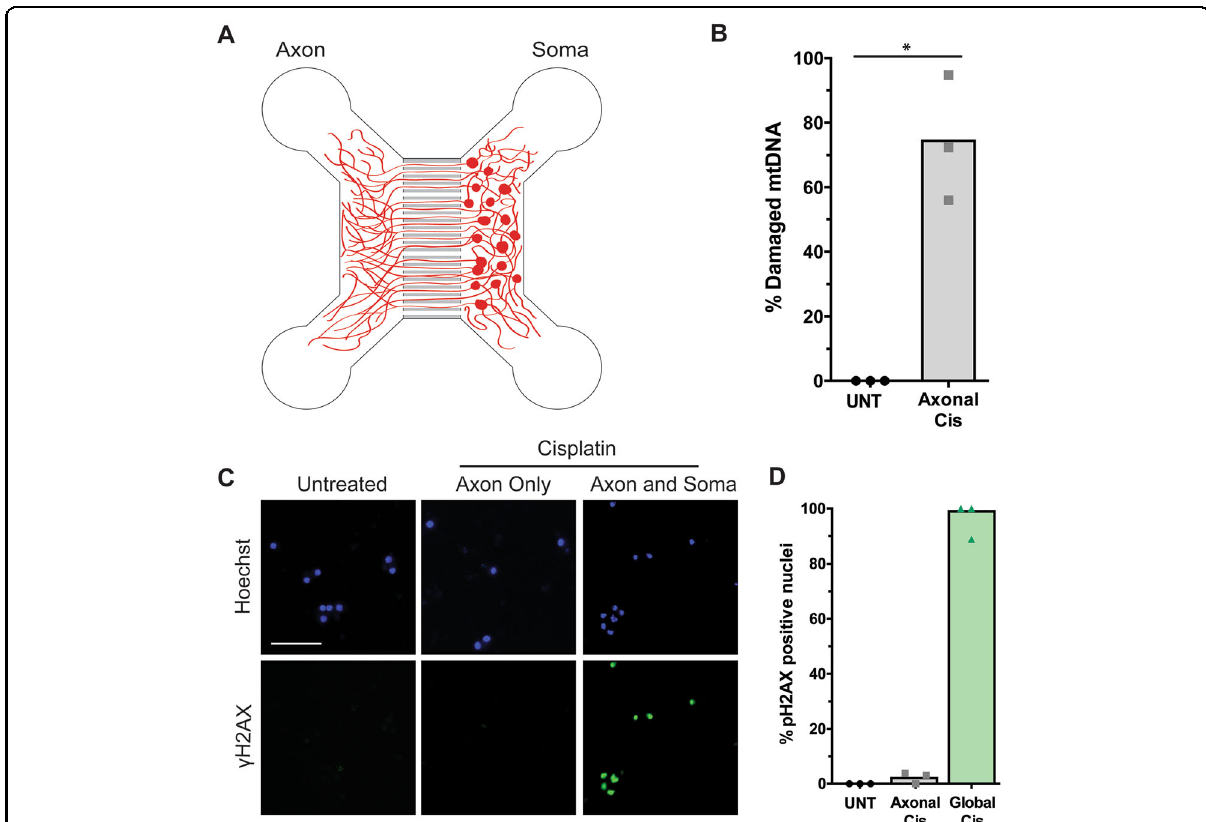
Fig. 1 Axon-only exposure to cisplatin in compartmentalized cultures induces axonal mtDNA damage without damaging nuclear DNA. A Illustration of the micro fl uidic chambers where neurons are placed in the soma compartment and allowed to extend their axons into the axon compartment through the microgrooves separating the two compartments. B Neurons in micro fl uidic chambers were either left untreated (UNT) or treated with 20 µM cisplatin to the axon chamber (Axonal Cis). Shown is quanti fi cation of mtDNA damage represented as % undamaged mtDNA in axonal mitochondria after 24 h of exposure as compared to untreated controls ( n = 3); individual data points and mean are depicted. Paired t -test (two-tailed) (* p < 0.05). C Neurons in micro fl uidic chambers were left untreated (UNT) or treated with cisplatin to only the axon chamber (Axon only) or treated with cisplatin to both the compartments (Axon and Soma; Global). Shown are images of the neuronal soma stained with antibodies to ɣ H2AX and the corresponding images of nuclei stained with Hoechst at 120 h after treatment with 20 µM cisplatin. While ɣ H2AX foci in the nucleus are observed in globally treated neurons (cisplatin added to both axon and soma compartments), virtually no ɣ H2AX foci are visible upon cisplatin exposure to the axon-only compartment. The scale bar illustrated here represents 100 μ m. D Quanti fi cation of ɣ H2AX staining ( n = 3), individual data points and mean are